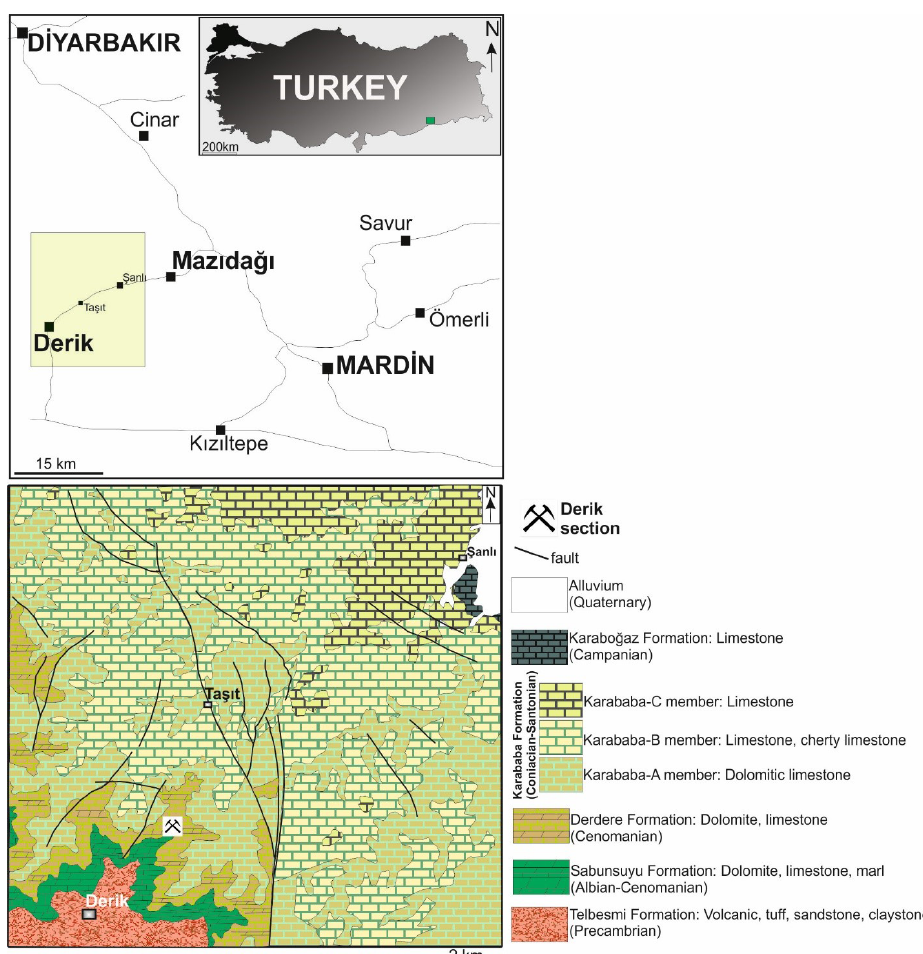
Figure 2. Location of the studied section. Regional geological map (following Beer, 1966; MTA,